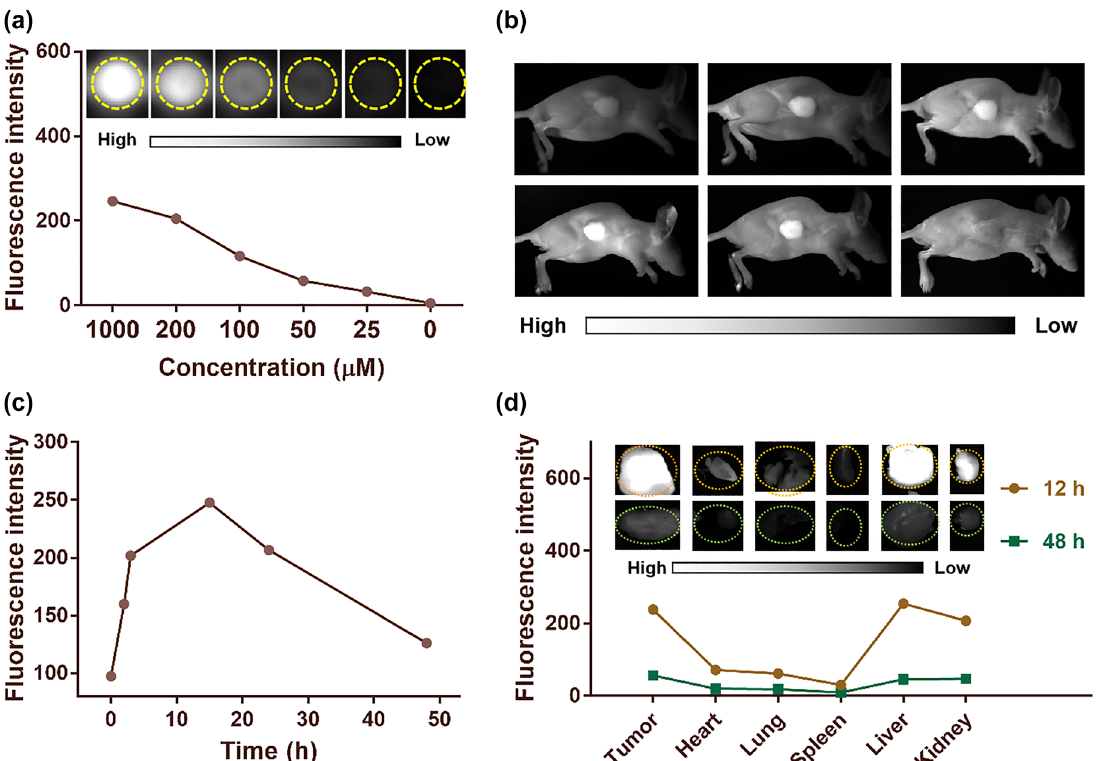
Figure 4: In vivo fluorescence imaging. (a) Fluorescence intensity of SQ NPs in different concentrations. (b) And (c) are fluorescence imaging images of mice and average fluorescence intensity of tumor sites after injection of SQ NPs with time. (d) Mean fluorescence intensities and (inset) images of mice tumor and major organs at 15 and 48 h after injection of SQ